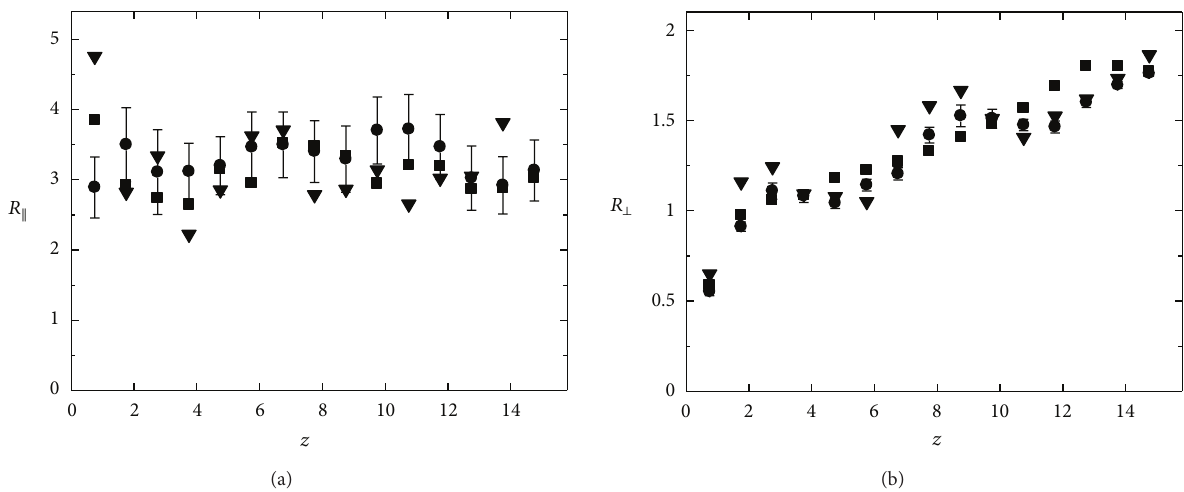
Figure13:Radiusofgyrationasafunctionofthedistancefromthewall, 𝑧[𝜎] ,for 𝑁 𝑝 = 10 :(a)parallelcomponent 𝑅 ‖ [𝜎] and(b)perpendicular component 𝑅 ⊥ [𝜎] for ( ◼ ) 𝜀 𝑝 𝑏 = 𝜀 𝑝 𝑤 = 0 , ( ∙ ) 𝜀 𝑝 𝑏 = 𝜀 𝑝 𝑤 = 𝜀 , and ( 󳶃 ) 𝜀 𝑝 𝑏 = 𝜀 𝑝 𝑤 = 2𝜀 . Error bars indicate one-half of the standard deviation and are shown only for 𝜀 𝑝 𝑏 = 𝜀 𝑝 𝑤 = 𝜀